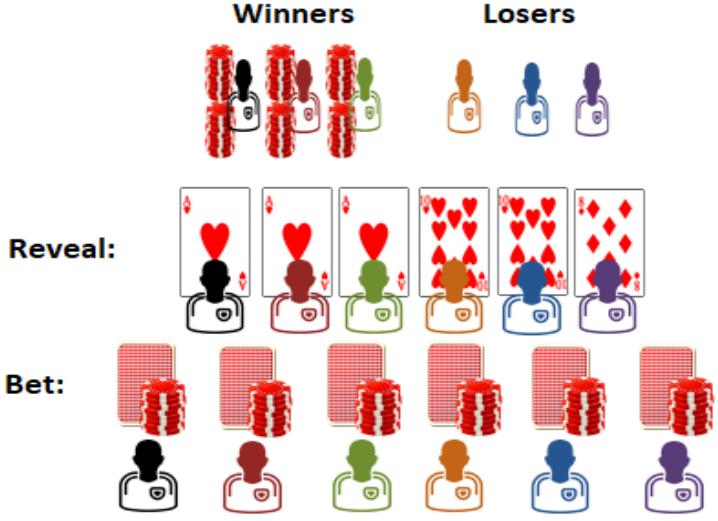
Figure 8. Proposed OPF solution scheme explained using a card betting game.